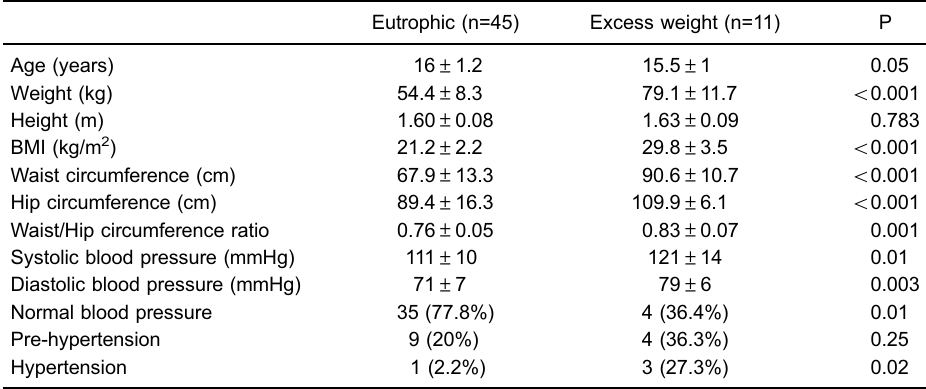
Table 1. Comparison of clinical characteristics of adolescents with and without excess weight (overweight and obesity) in a public school in Fortaleza, CE, Brazil, October 2015 to August